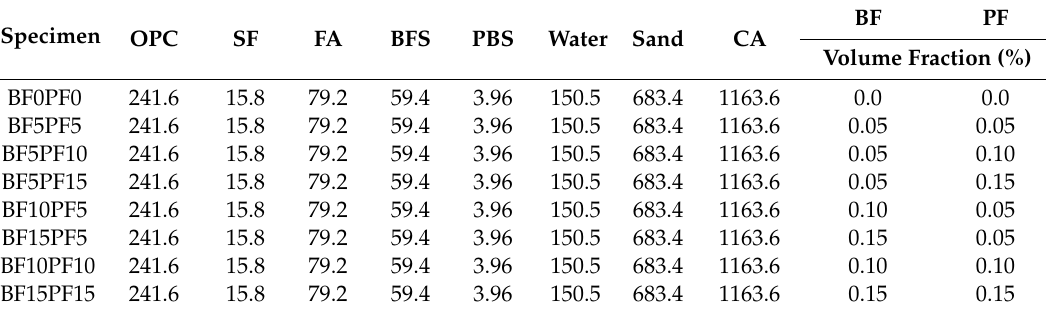
Table 3. Mix proportions of concrete (kg/m 3 ).